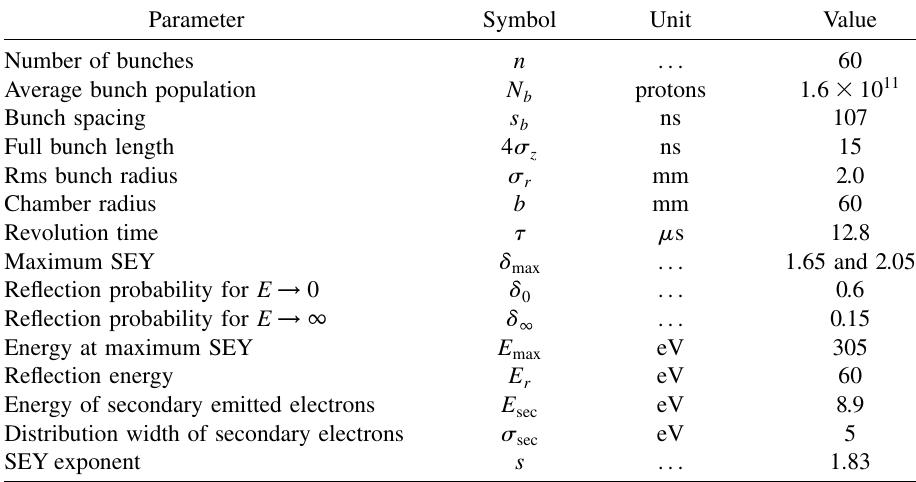
TABLE II. List of beam parameters during the energy spectrum measurement. The second part of the Table shows the SEY parameters used in the CSEC simulations, whose meaning are found in Ref.